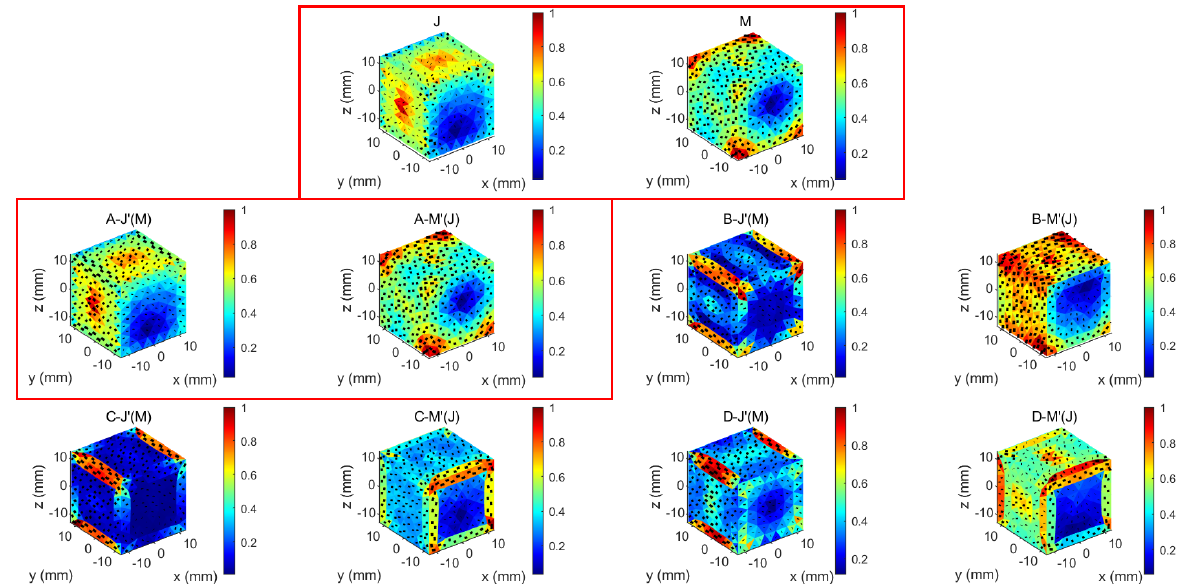
Figure 5. Comparison of characteristic electric and magnetic current distributions (J, M) of mode 13 (physical mode) obtained from Equation (19) at 2.0 GHz, with other corresponding currents (J’(M), M’(J)) generated by submitting (M, J) into boundary conditions of problems (A), (B), (C) and (D).